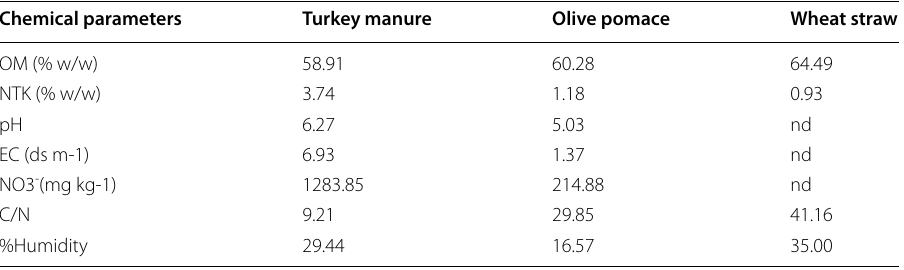
nd not determined, w/w weight/weight